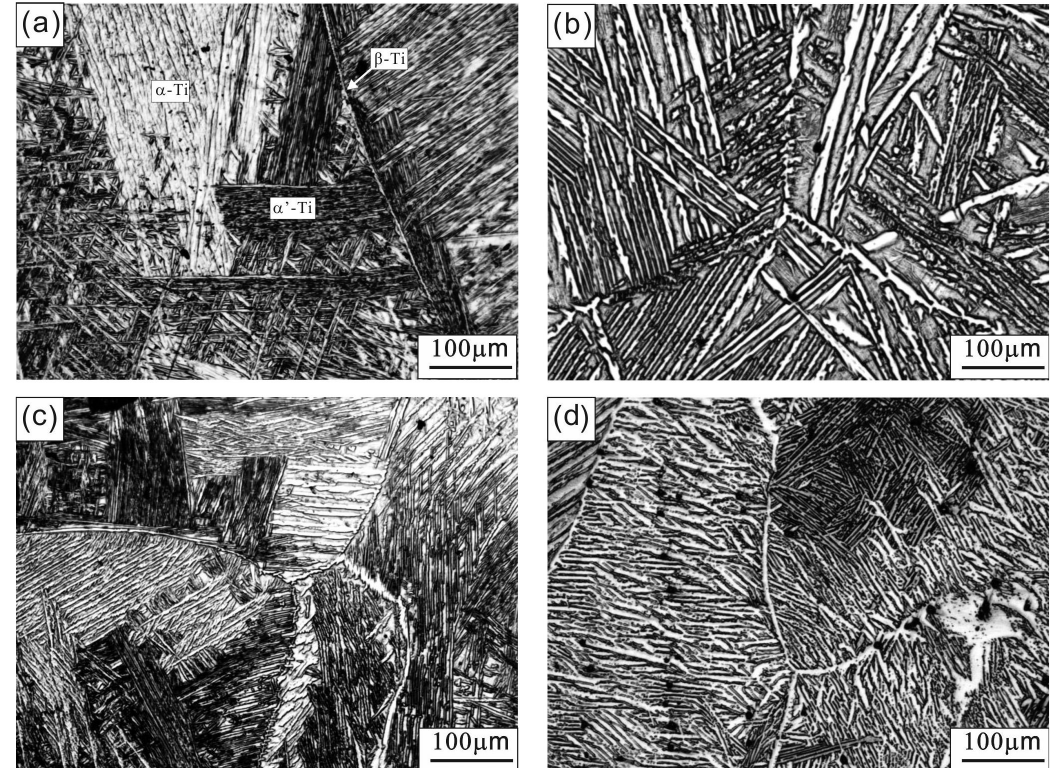
Figure 1. Optical micrographs of the Ti15Sn x Cu alloys: (a) AS Ti15Sn, (b) HT Ti15Sn, (c) AS Ti15Sn2Cu and (d) HT Ti15Sn2Cu.